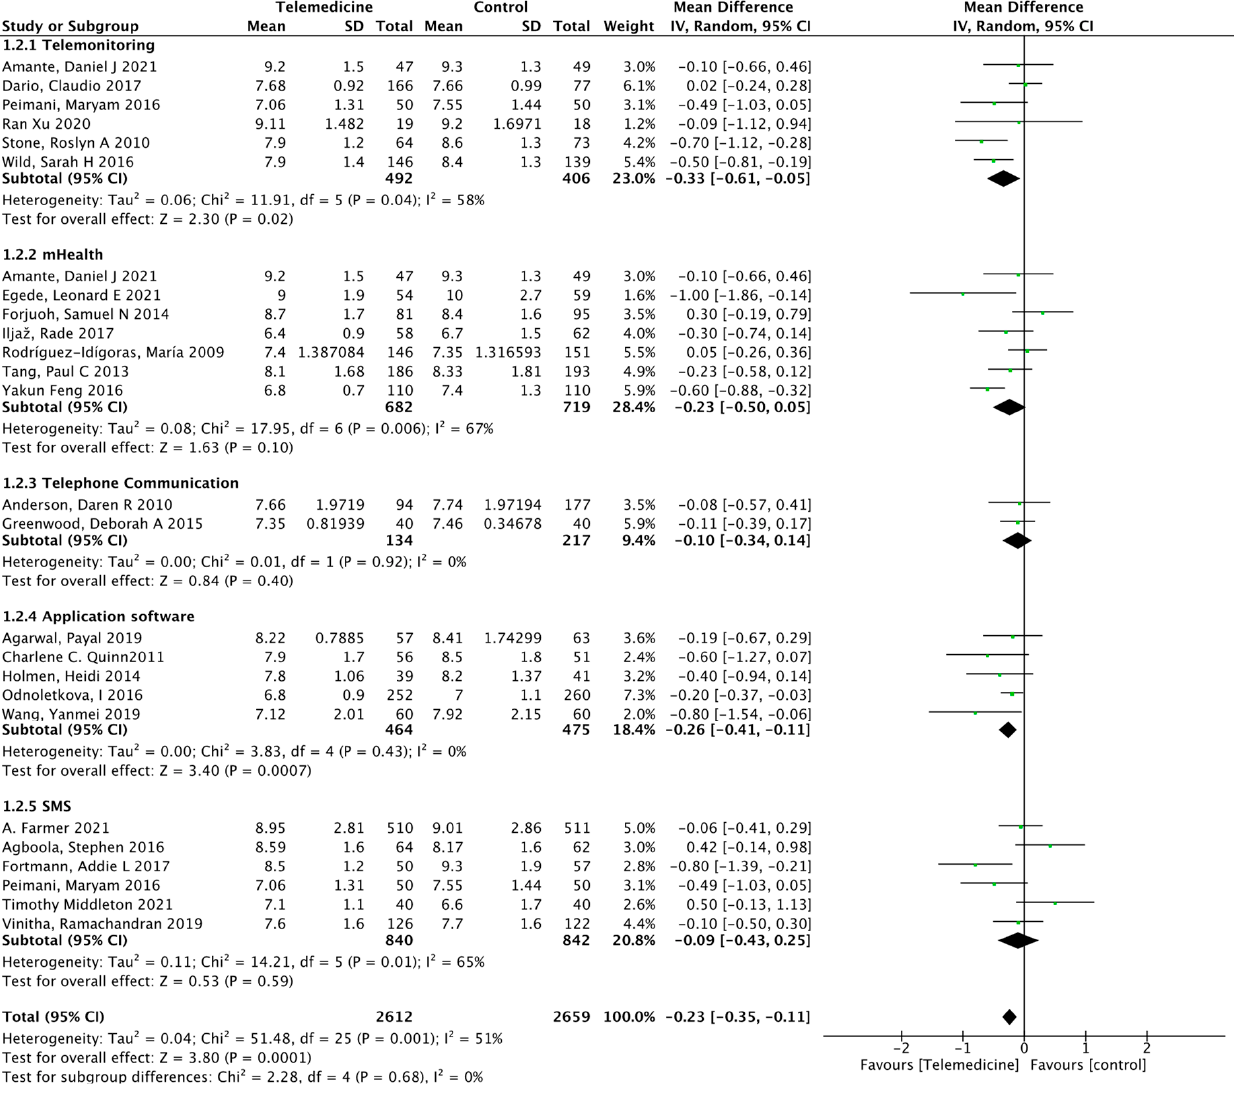
Figure 6. Mean difference in the changes in FBG levels for telemedicine and usual care interventions.